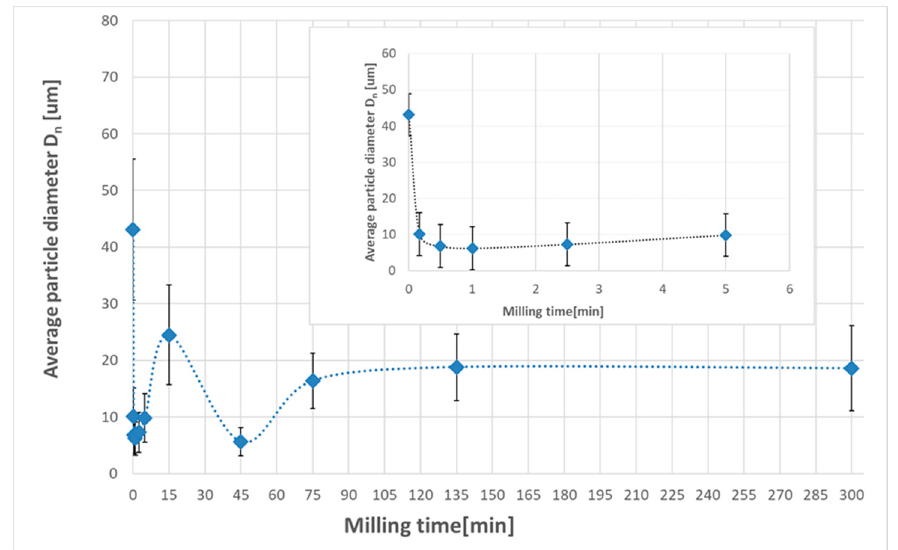
Figure 2. The changes in the average particle diameter D n for as-received and milled MgH 2 powders.